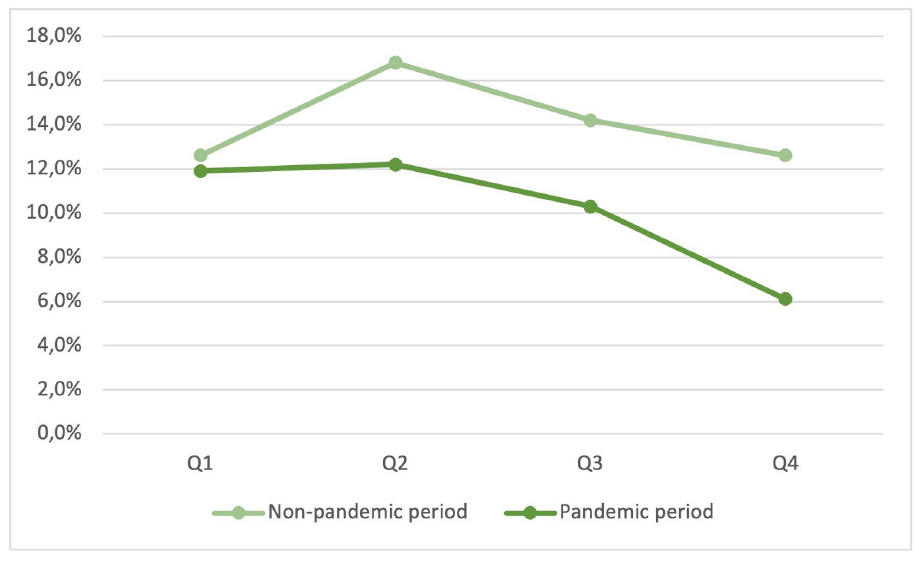
Fig 3. Survival at hospital